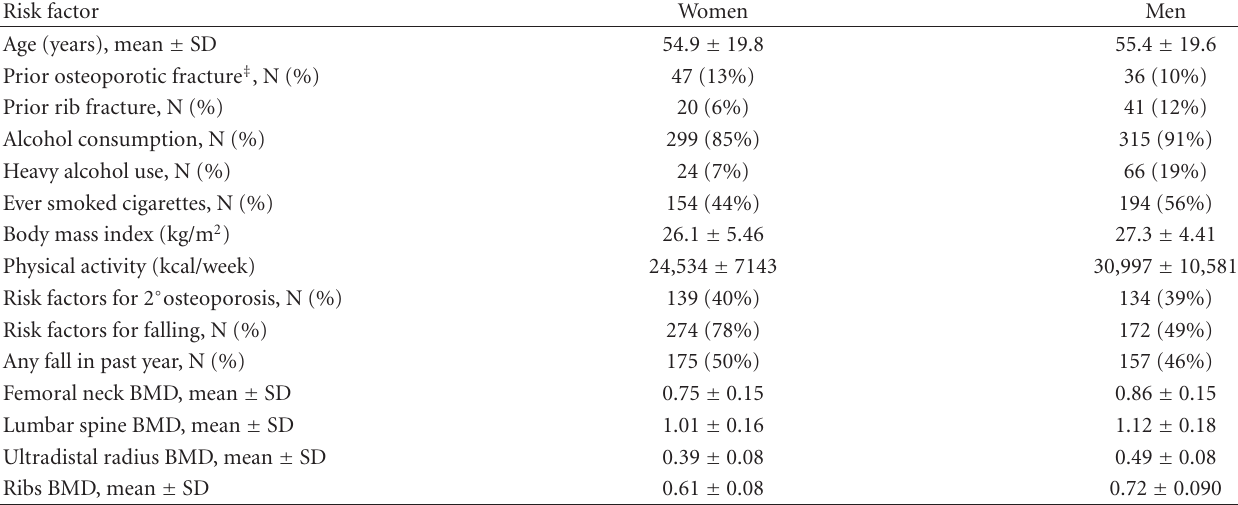
Table 1: Characteristics at baseline among 351 Rochester, Minnesota, women and 348 Rochester men followed for rib